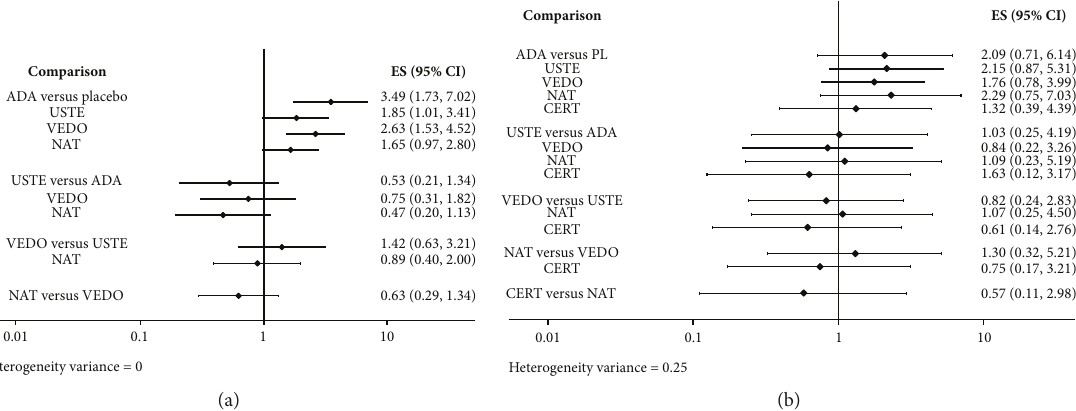
Figure 4: Network meta-analysis interval plot of published studies for induction of (a) remission and (b) response in anti-TNF-experienced CD patients. Odds ratios (ORs) with 95% con fi dence interval (CI) are reported. All the single drugs showed consistent e ffi cacy comparing with placebo while no drug proved to be superior in a statistically signi fi cant level to all others in inducing remission. ADA=adalimumab; USTE=ustekinumab; VEDO=vedolizumab; NAT=natalizumab; CERT=certolizumab; PL =placebo.